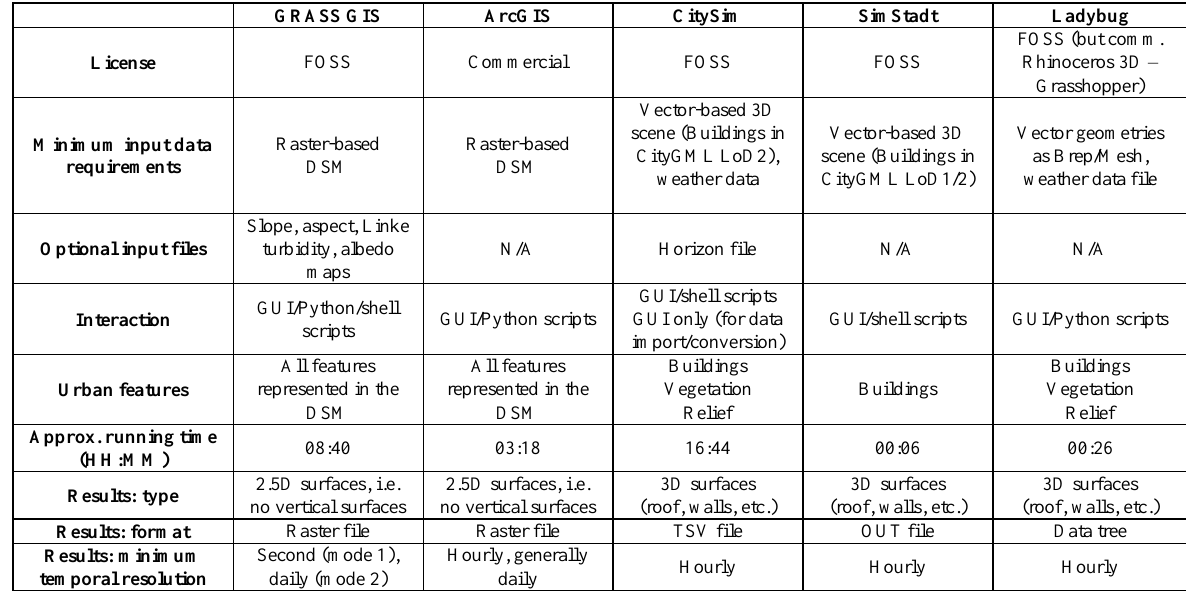
Table 1. Comparison of the tested simulation tools for solar irradiance. Tests were carried out on a MacBook Pro equipped with a